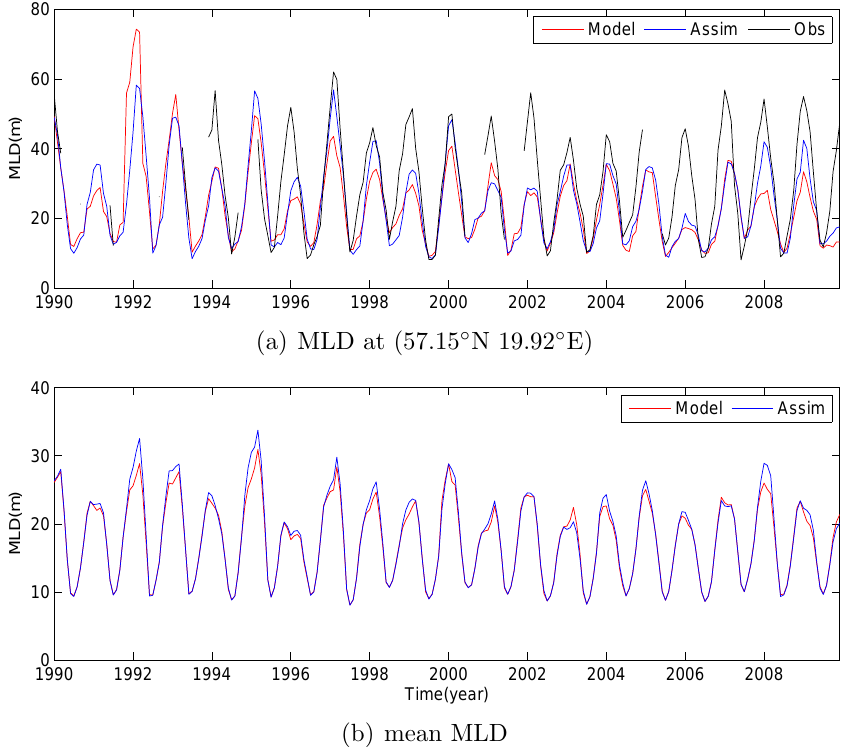
Fig. 12. The evolution of mixed layer depth (MLD) calculated from the free run and Figure 12: The evolution of mixing layer depth (MLD) calculated from the free run and reanalysis.